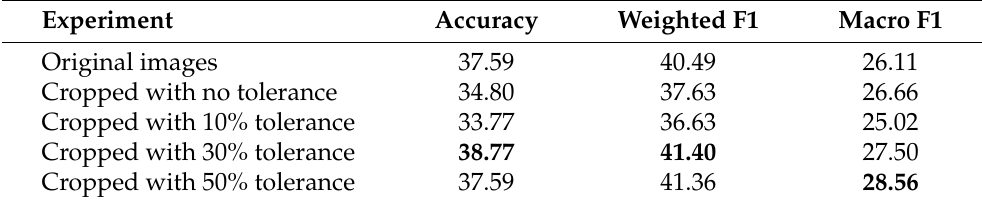
Table 3. Metrics score of test set 1 for segmentation effect in lesion classification (in